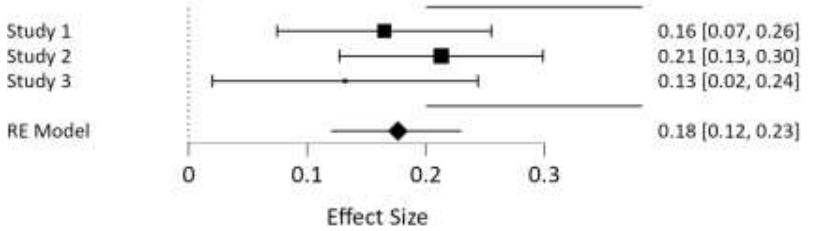
Figure 16. Forest plot of meta-analysis of Motivation for achievement and Agreeableness